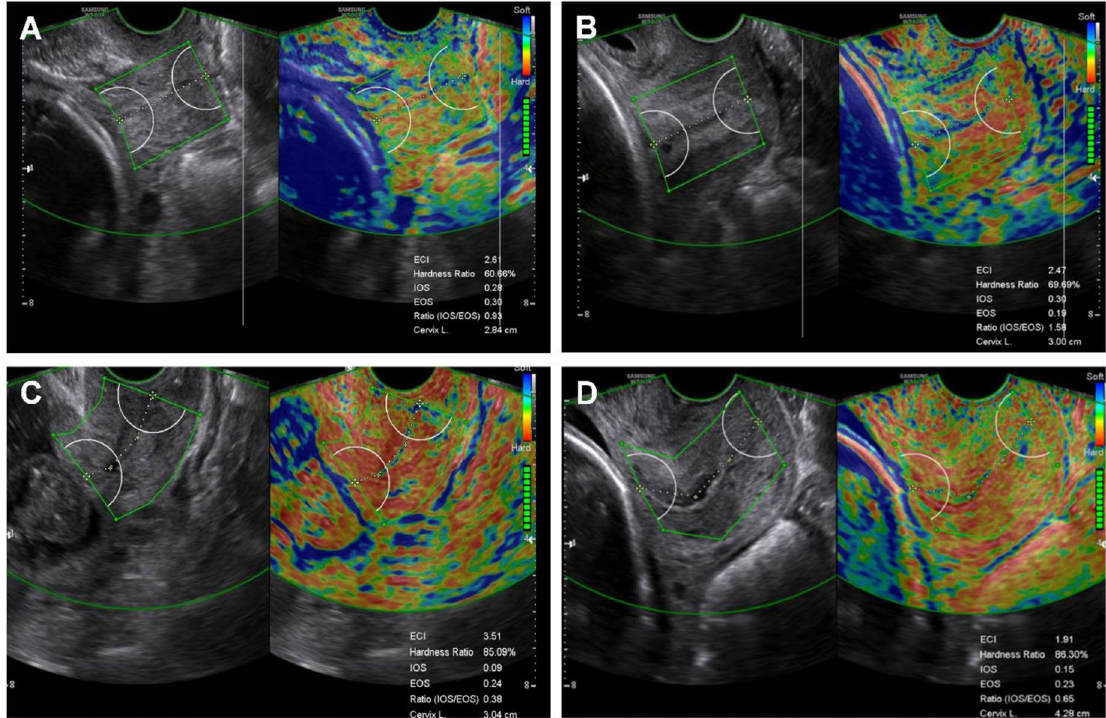
Figure 2. Images of cervical elastography using the E-cervix system. We identified the mid-sagittal plane of the cervix in which the endocervical canal is clearly delineated and the anterior width of the cervix is equal to the posterior width. Cervical elastogram in women in the LEEP group ( A ) and the control group ( B ) using 2-point ROI when the endocervical line is straight. Cervical elastogram in women in the LEEP group ( C ) and the control group ( D ) using 4-point ROI when the endocervical line is curved. LEEP loop electrosurgical excision procedure, ROI region of